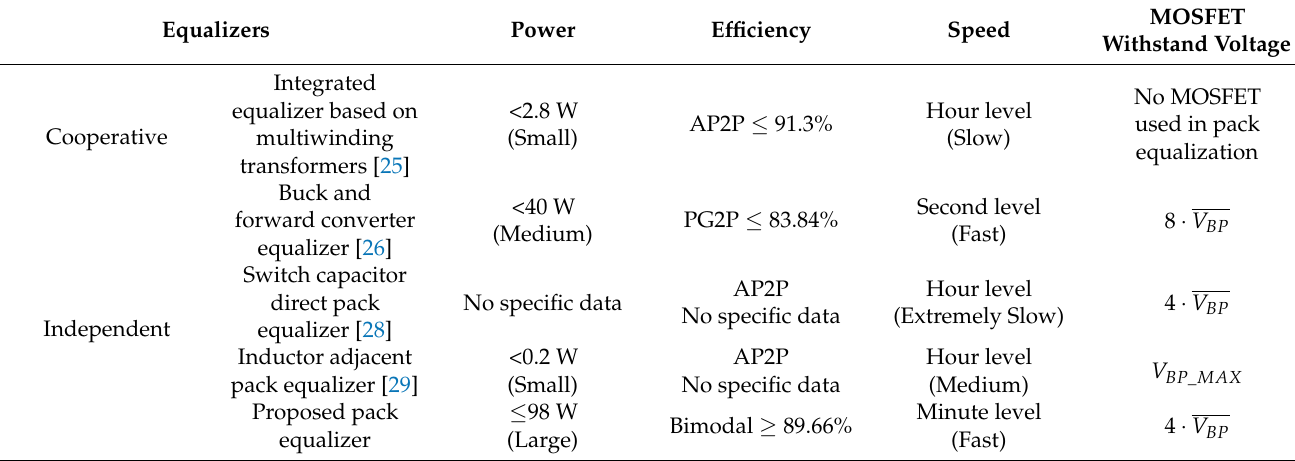
Table 8. Comparison of the pack equalizers in terms of pack level balancing performance.